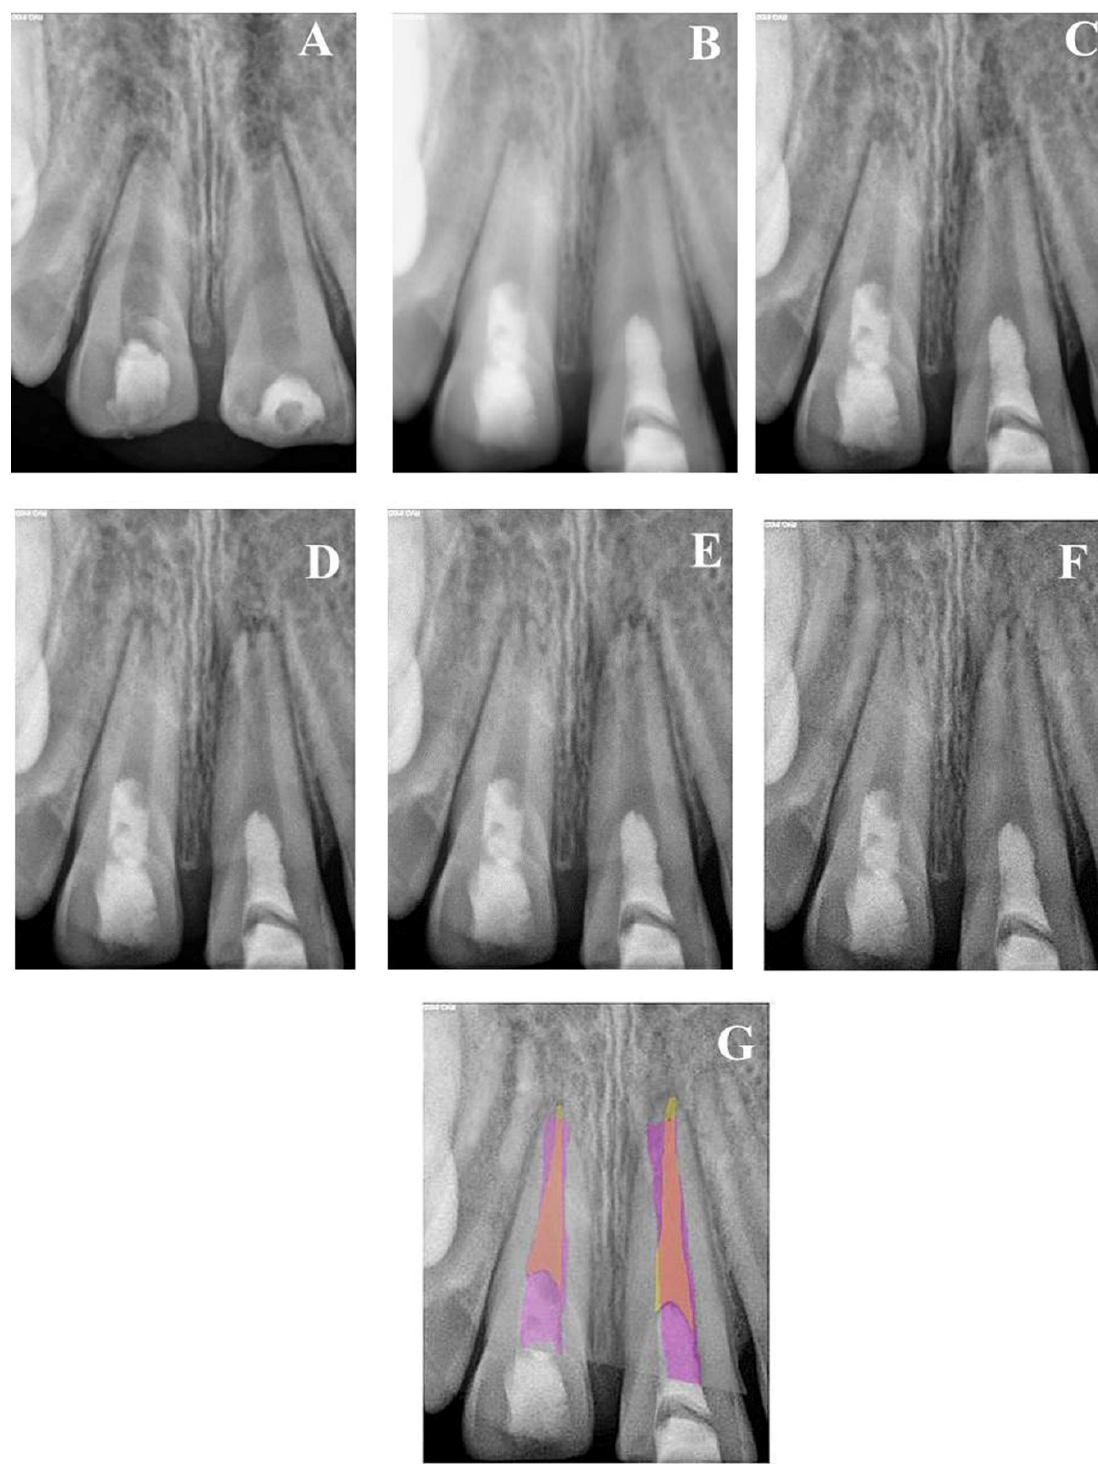
Figure 2. ( A ) Periapical radiograph of traumatized nonvital teeth #11 and 21 of a 9-year-old with wide open apices and periapical radiolucency; ( B ) immediate post-treatment radiograph showed MTA plugs in the coronal third of both teeth and composite restorations; ( C ) a follow-up photoradiograph after 6 months showed complete resolution of the periapical radiolucencies; ( D – F ) follow-up photoradiographs at 12 months, 24 months, and 8 years, respectively, showed narrowing of the apical foramen and further apical closure; ( G ) overlapped periapical radiographs of immediate post-treatment and at 8 years of follow-up showed significant changes in root length and width of apical canal.